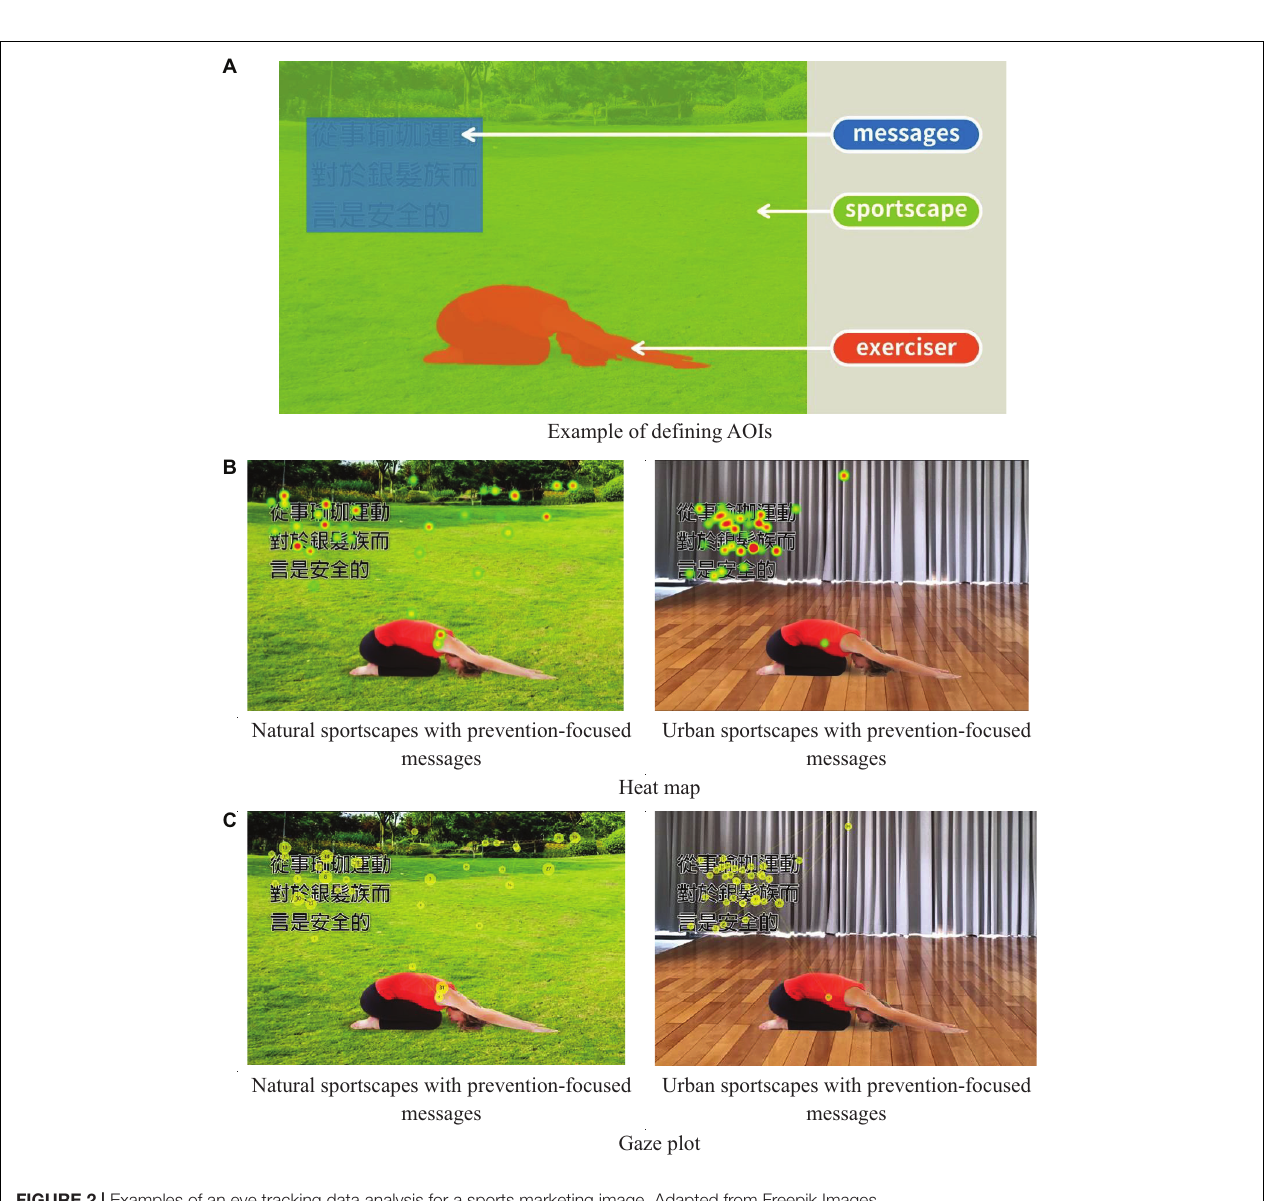
FIGURE 2 | Examples of an eye tracking data analysis for a sports marketing image. Adapted from Freepik Images.